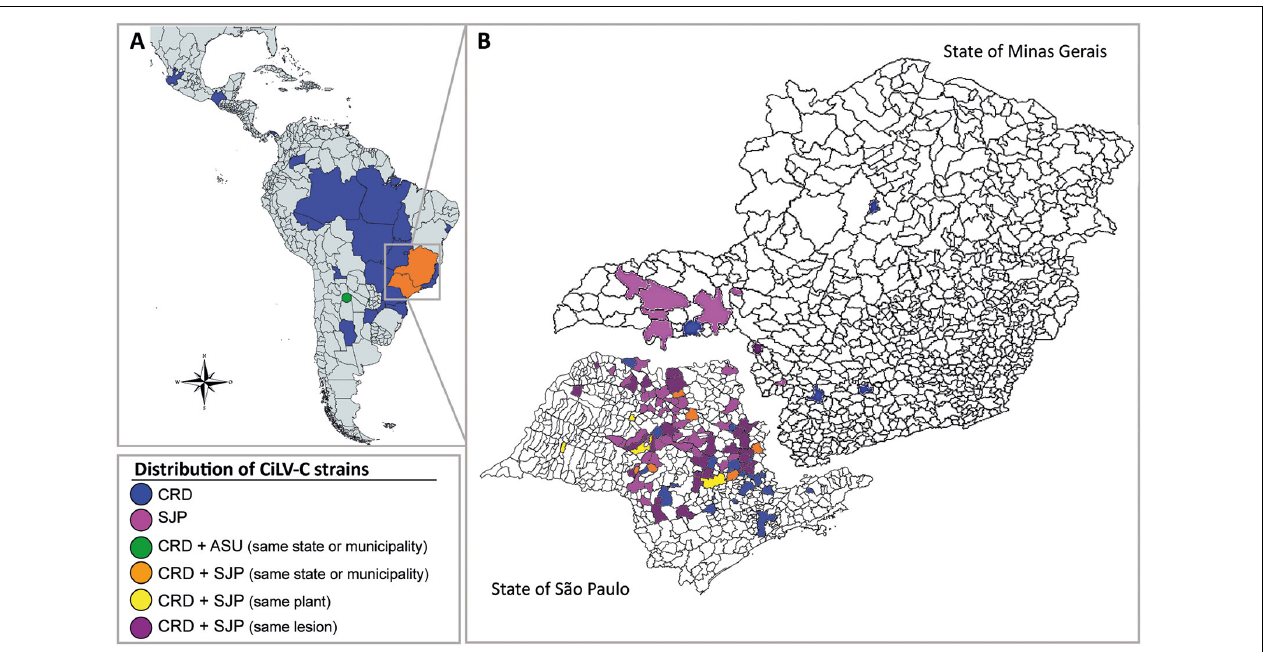
FIGURE 5 | Distribution of CiLV-C strains in Latin America (A) and across municipalities in the Brazilian states of São Paulo and Minas Gerais (B) in the period from 1932 to 2020. Viral detection was based on RT-PCR assays for specific identification of p29 and p24 from isolates of the CRD and SJP clade. CiLV-C_ASU was identified by high-throughput sequencing. The color-coded legend indicates the presence of a viral isolate, concomitantly or at a different time in the same plant, in single or mixed infections. The map also depicts the distribution of CiLV-C isolates whose sequences were already available in the GenBank database.